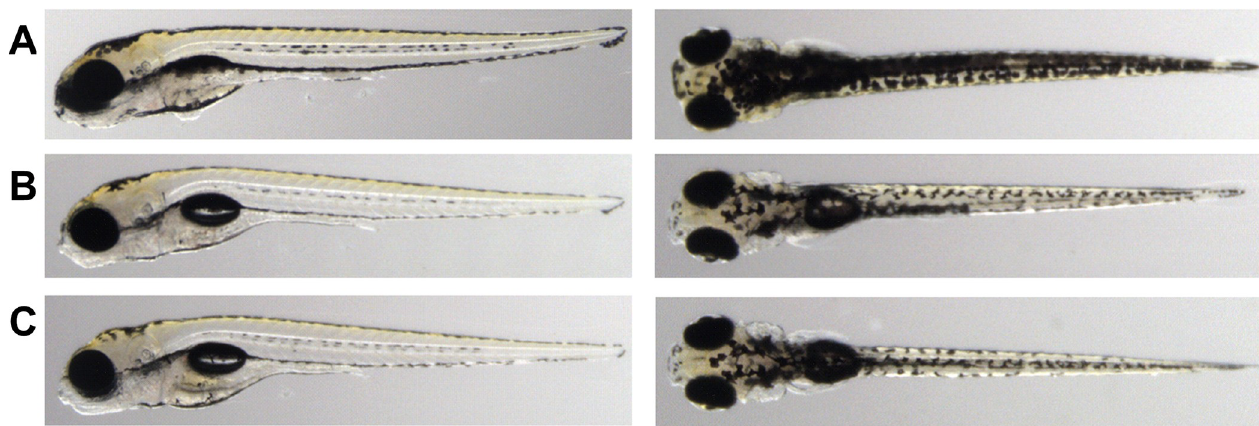
Fig 1. Morphology of the Scn1Lab knockout. A) 5 dpf Scn1Lab homozygous knockout larvae show hyperpigmentation and the absence of an inflated swim- bladder. These morphological defects are absent in heterozygous (B) or wildtype (C) zebrafish larvae.